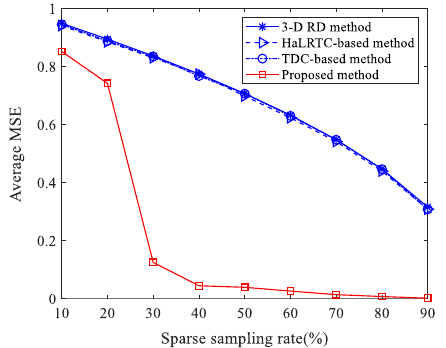
Fig. 7 Trend of average MSE between different methods based on sparse data with various SSRs. The SNR is set to be 10